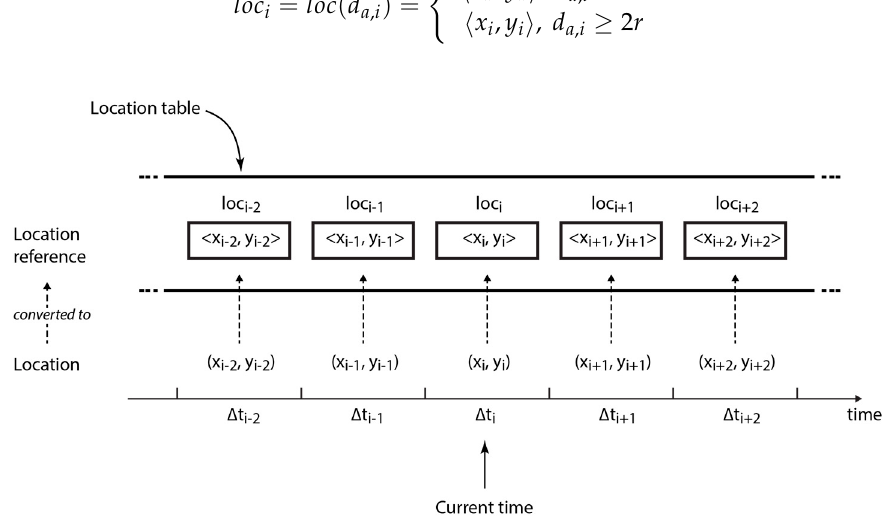
Figure 12. Structure of the location table.